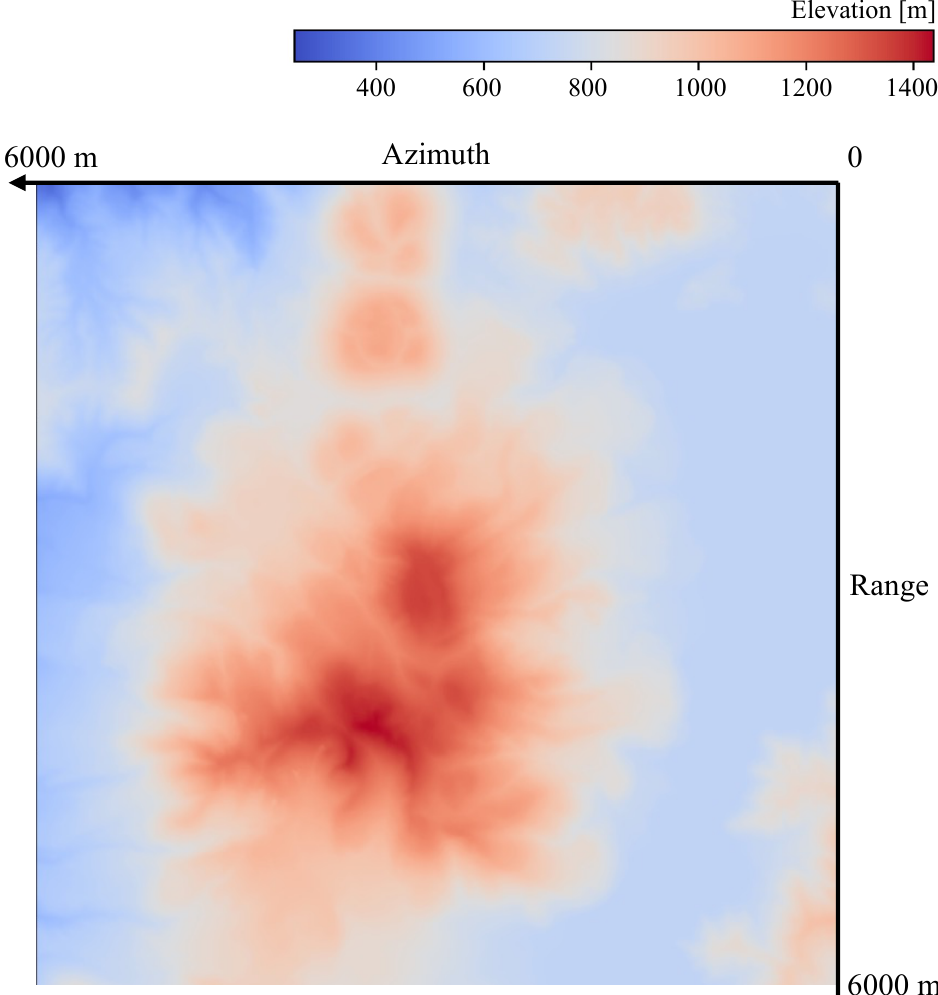
Figure 18. Elevation extracted from the GSI DEM around Mount